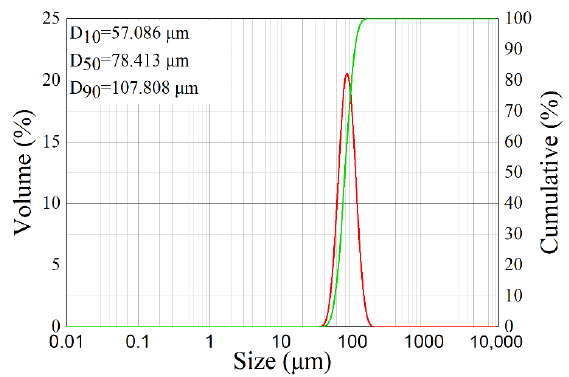
Figure 3. Particle size distribution of the alloyed powder.